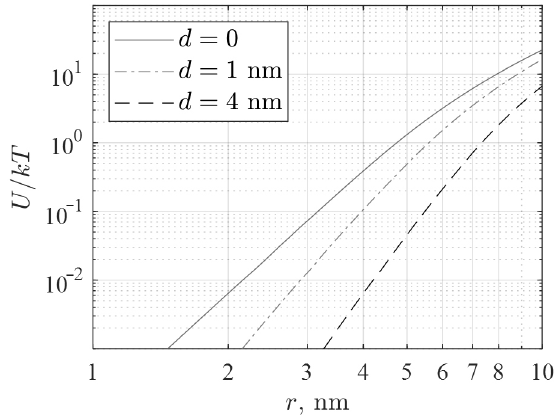
Figure 11. Dependence of the relative value of the magnetic interaction U / kT on the radius r of two contacting IONPs without shells and at different shell thicknesses d : 1 nm for the citrate shell and 4 nm for the protein shell.